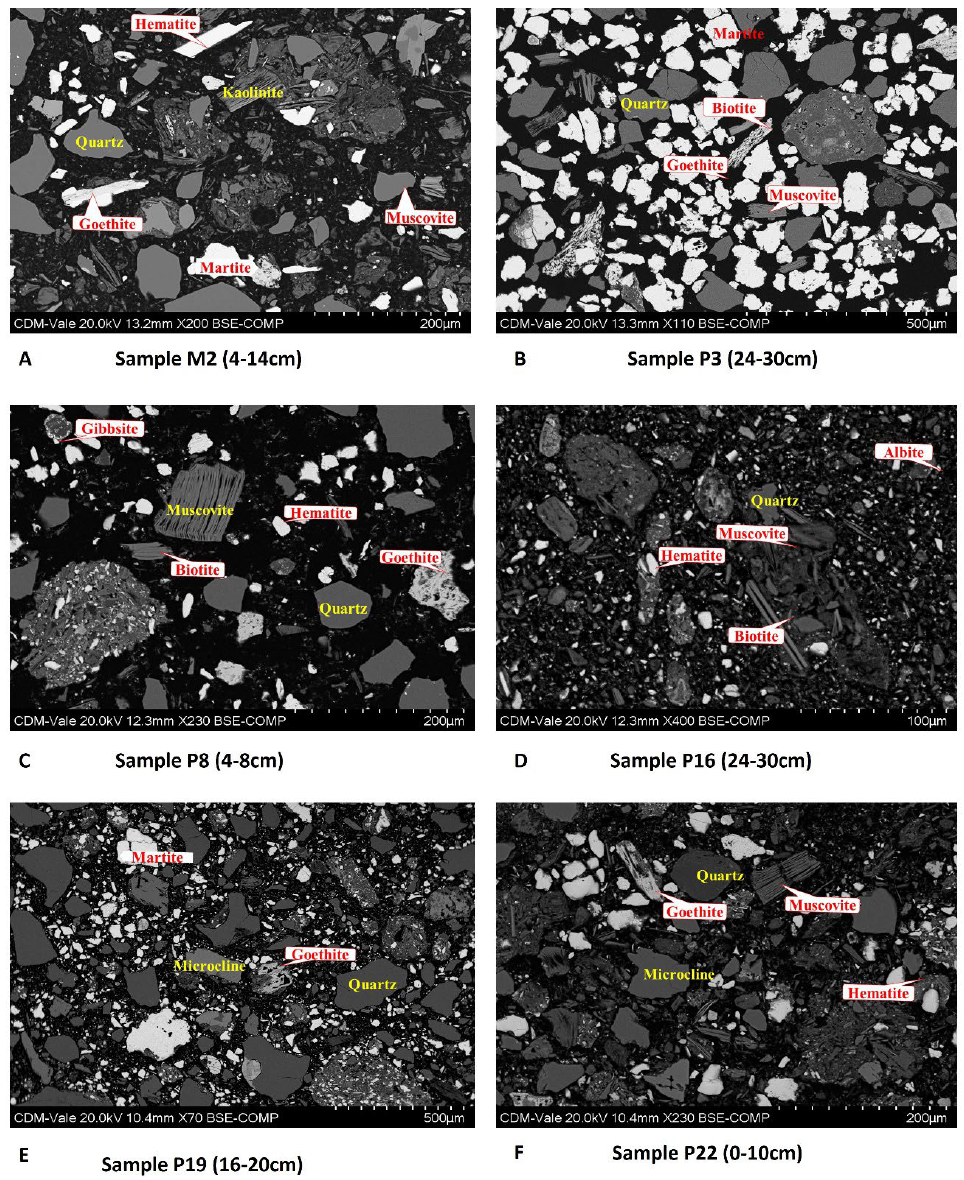
Figure 4. SEM BSE images of the analyzed borehole samples: ( A ) Sample M2, ( B ) Sample P3, ( C ) Sample P8, ( D ) Sample P16, ( E ) Sample P19 and ( F ) Sample P22.